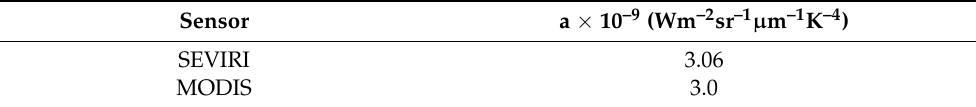
Table 2. Sensor-dependent constants